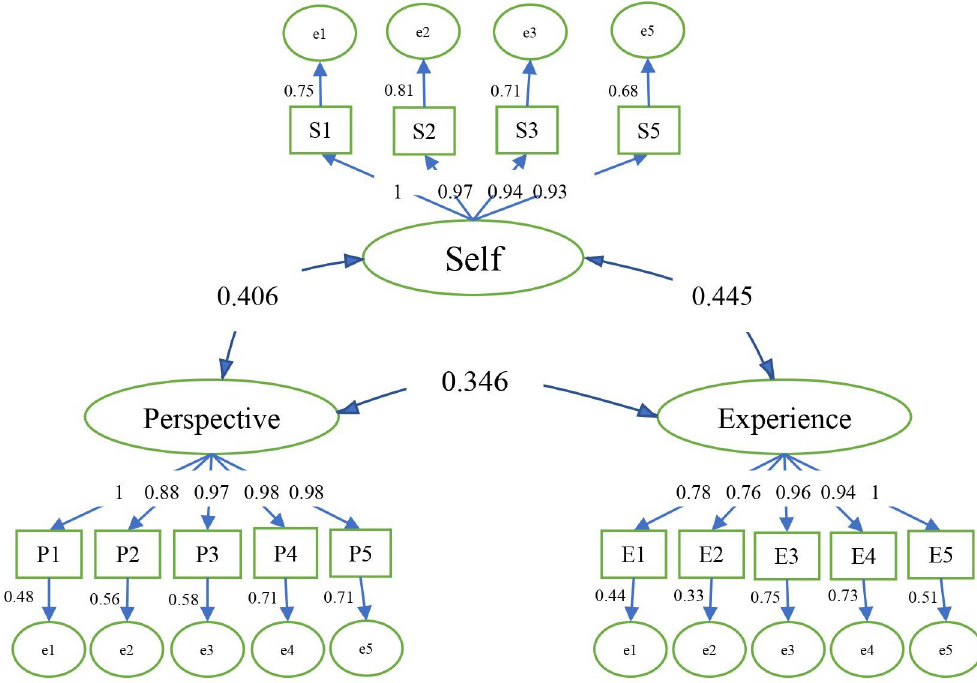
Fig 2. The values of the squared multiple correlation (SMC) of NR.